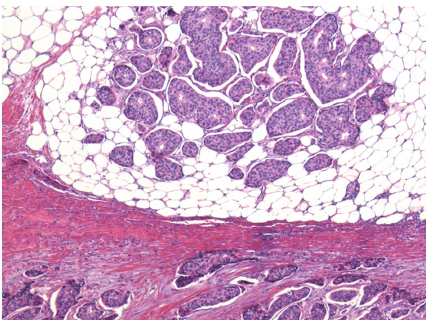
Figure 1: Mastectomy specimen with invasive ductal carcinoma. Duct-like structures and nests are seen invading the breast stroma and fat. (Hematoxylin and eosin stain, original magnification × 100.)